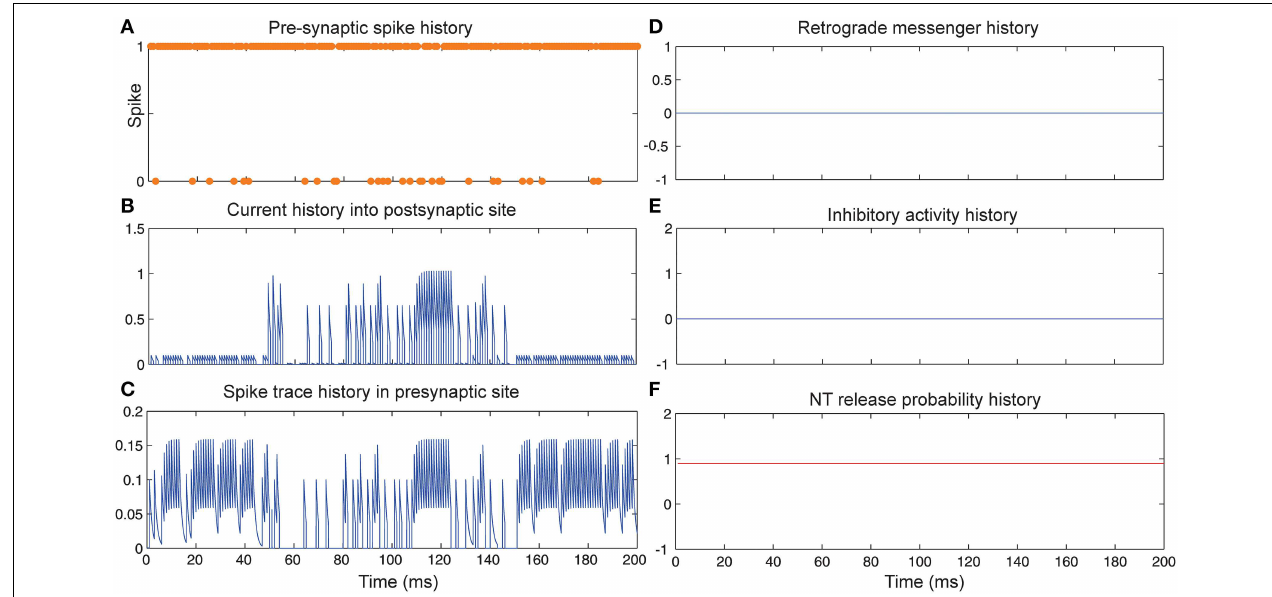
FIGURE 3 | The dynamics of model’s parameters in the presence of Hebbian mechanism and absence of homeostatic regulation of neurotransmitter release. (A) Spike train history of a presynaptic neuron with firing probability equal to 0.85 in 200 time bins. (B) Current history into the postsynaptic site triggered by presynaptic neuron’s spiking. In time bins between 50 and 150 Hebbian rule was applied to the model while in the postsynaptic site production of retrograde